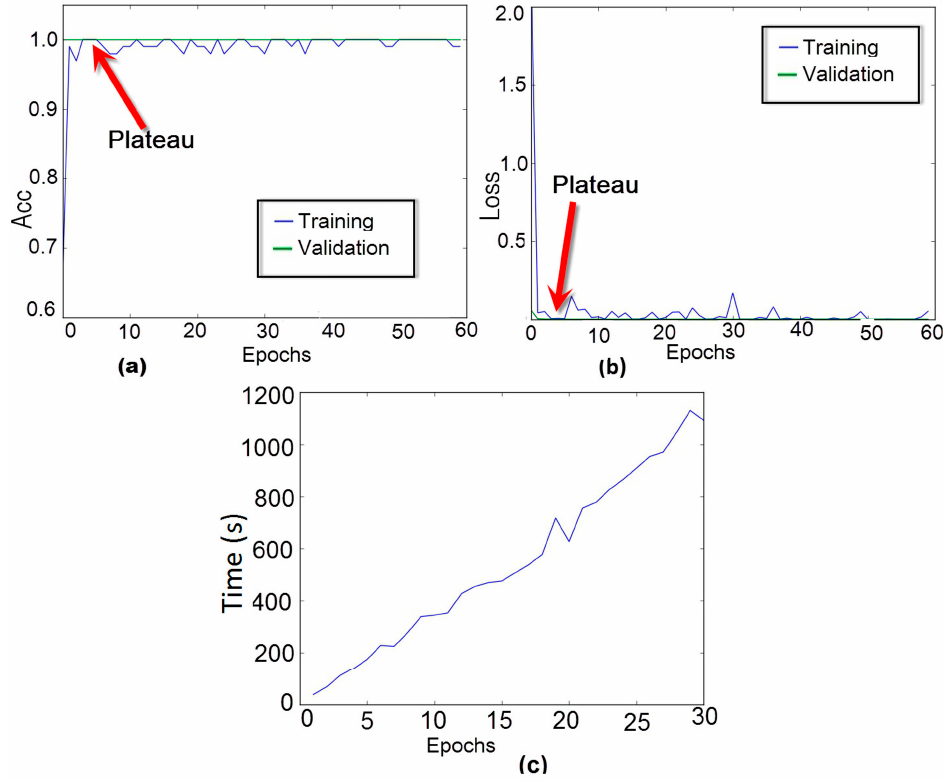
Figure 14. Performance analysis of the CNN for PZT#2: ( a ) training and validation accuracy curve of the model as a function of epoch; ( b ) training and validation loss curve of the model as a function of epoch; ( c ) Consumption time versus number of epoch for the training phase.